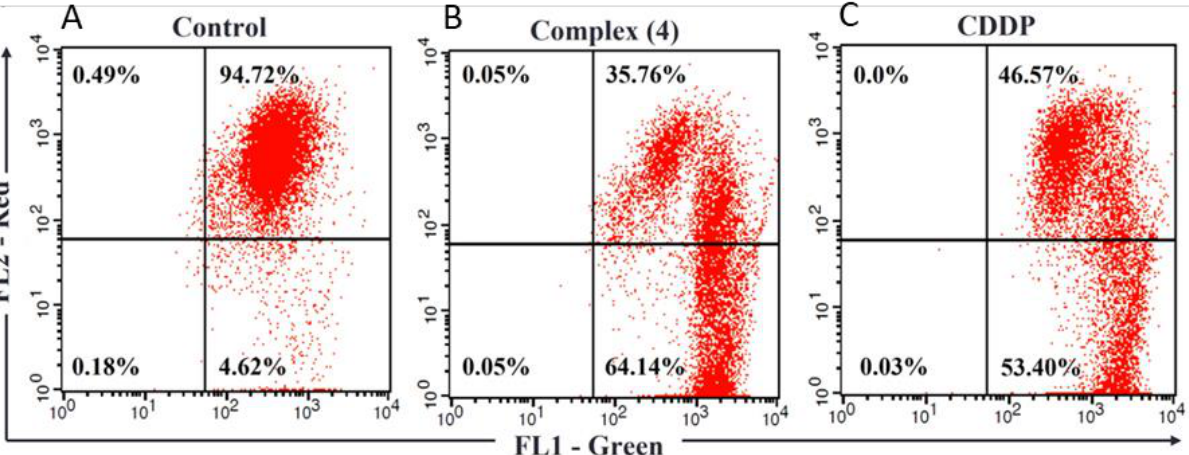
Figure 2. Mitochondrial transmembrane potential ( ∆Ψ m) assay of MDA-MB-231 cells after 24 h of incubation. Cells were stained with JC-1 and analyzed using flow cytometry. Each dotplot shows the percentage of cells with ∆Ψ m loss, as indicated by the cell change from red fluorescence to green fluorescence. ( A ) Control cells. ( B ) Cells treated with 2 × IC 50 of complex ( 4 ). ( C ) Cells treated with 2 × IC 50 of CDDP. Data are representative of three independent experiments.